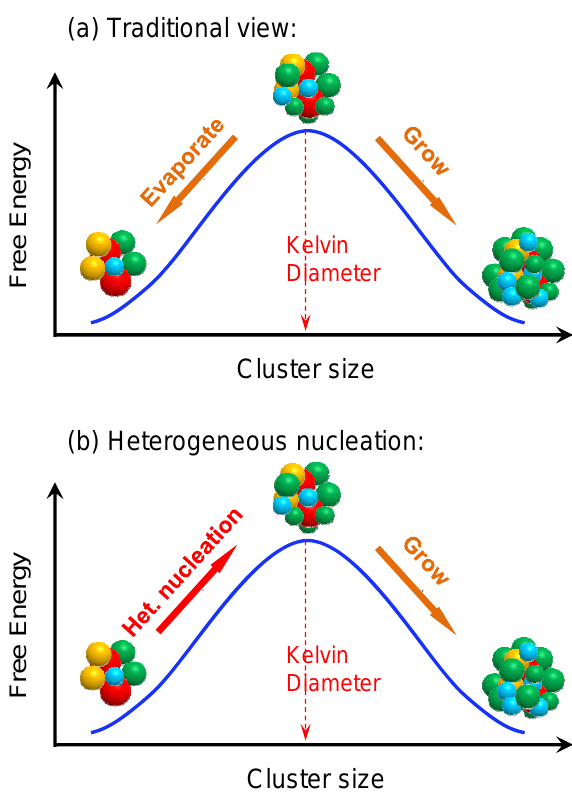
Fig. 2. (a) In traditional view, particles below the Kelvin diameter evaporate and only particles with diameter greater than the Kelvin diameter can grow through condensation; (b) based on heterogeneous nucleation theory, even particles below the Kelvin diameter can overcome the energy barrier and grow to larger sizes due to the net forward number flux.